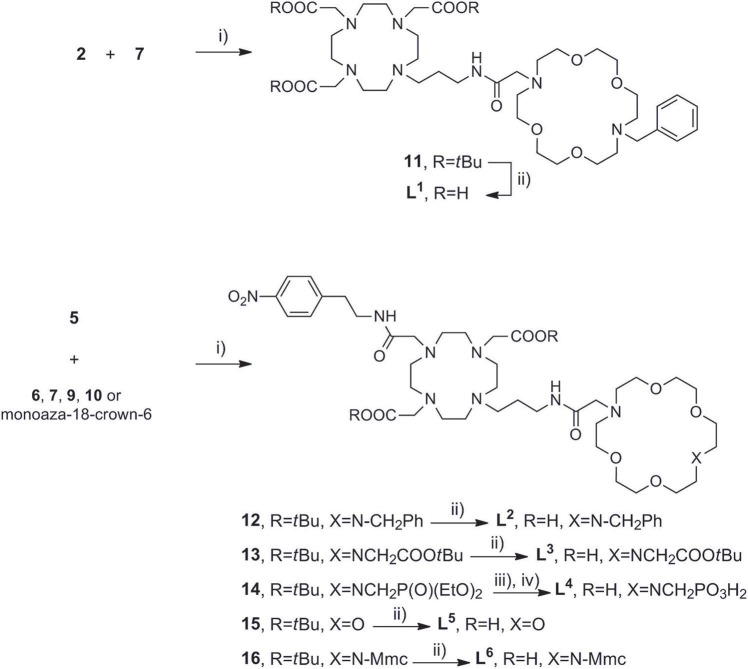
Synthesis of (A) DO3A derived ligand L1, (B) DO2A derived ligands L2−6. Reagents and conditions: (A) (i) dry DMF, N2, NaHCO3, 3 days, 70%; (ii) HCO2H, overnight, RT, 76%. (B) (i) dry DMF, N2, NaHCO3, 3 days, 25–78%; (ii) HCO2H, 32 h, 45°C; (iii) TMBS (16 equiv), dry DCM, N2; (iv) H2O, 50%.